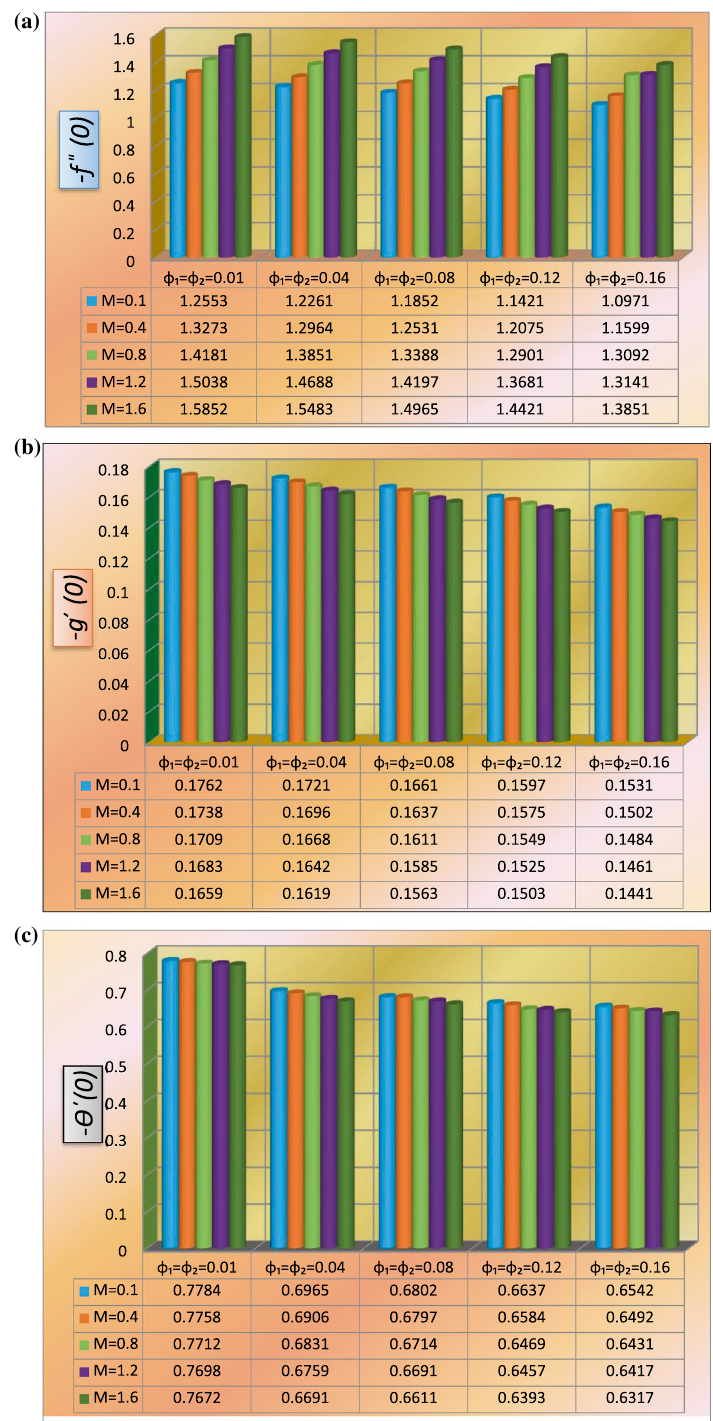
Figure 7. ( a ) Statistical variation of local skin friction − f ′′ ( 0 ) . ( b ) Statistical variation of local skin friction − g ′ ( 0 ) . ( c ) Statistical variation of local heat transfer rate − θ ′ ( 0 )